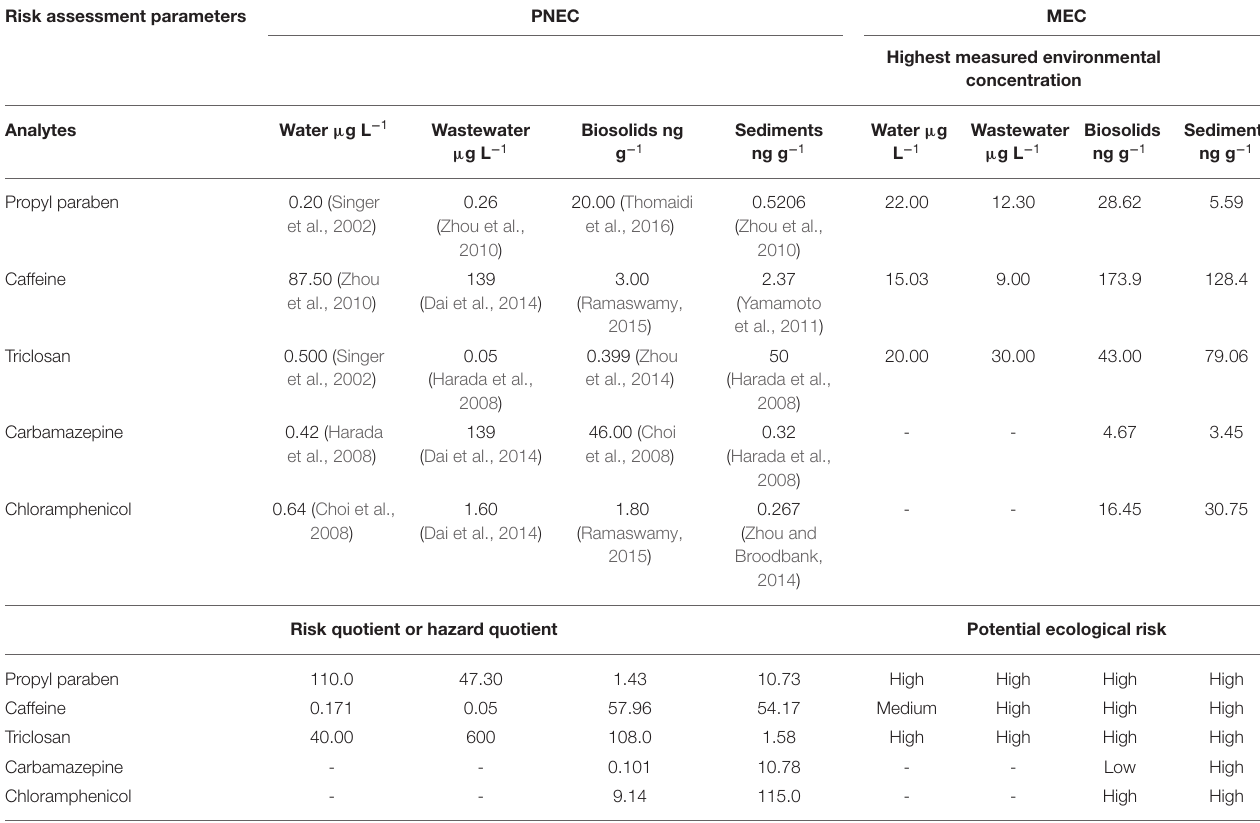
TABLE 7 | Potential ecological risk [in terms of RQ (MECs/PNECs)] of selected PPCPs in water, wastewater, biosolids, and sediments using maximum MEC